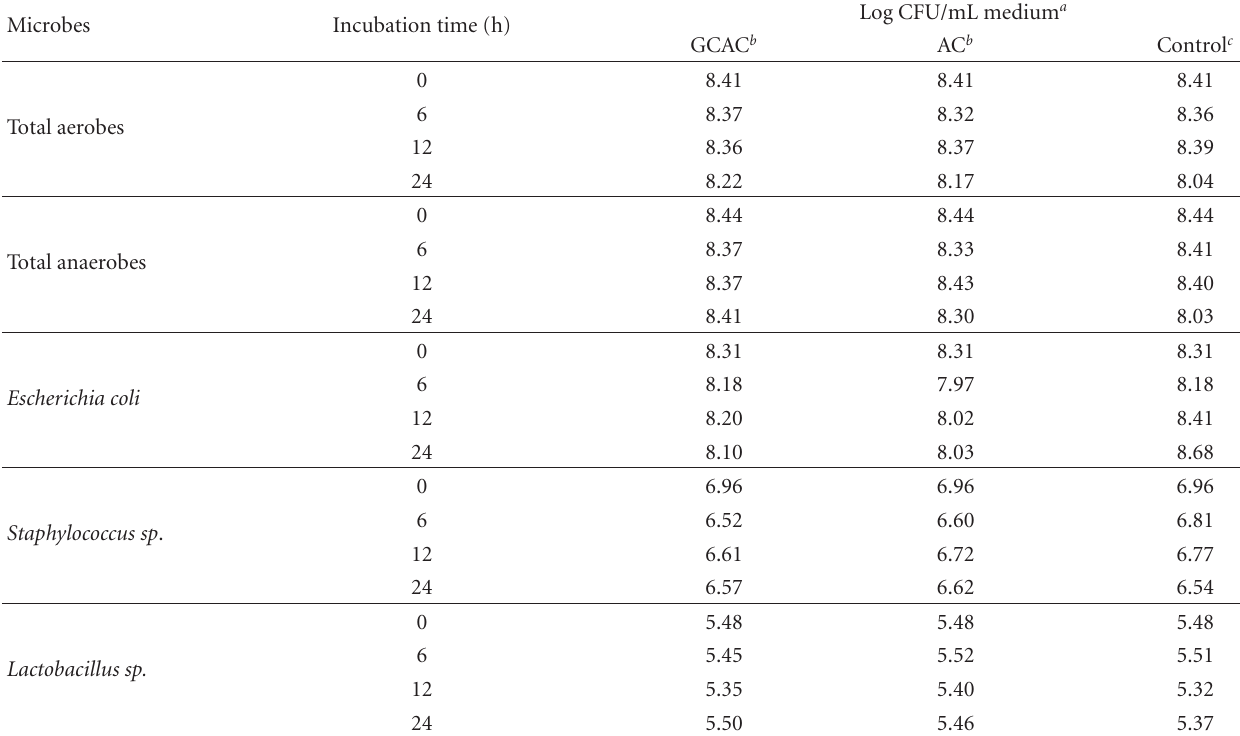
Table 3: E ff ects of microcapsules on fecal marker microbes in the simulated transverse colon.